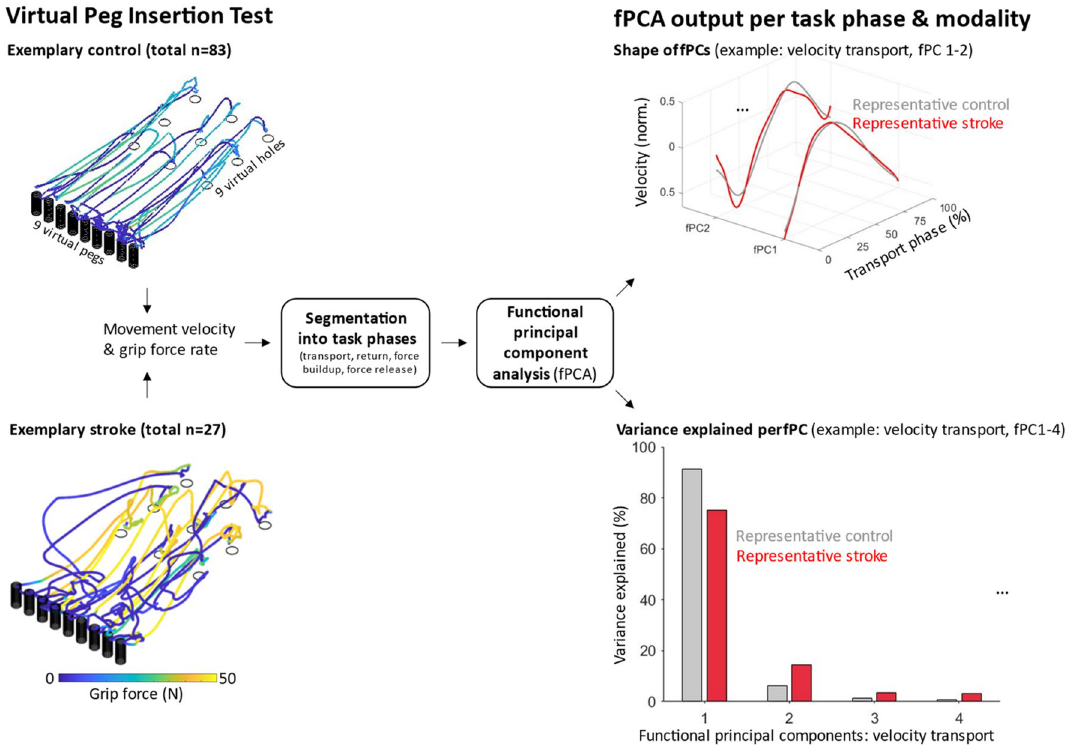
Figure 1. Overview of the approach to capture the control of arm movements and grip forces. Kinematic and kinetic time-series were collected in a control and post-stroke population using a technology-based assessment with a goal-directed functional task, the Virtual Peg Insertion Test (representative raw data in left panel). After a pre-processing and temporal segmentation (middle panel), functional Principal Component Analysis (fPCA) was applied. fPCA allows reconstructing the time-series with a set of low dimensional basis functions, named fPCs. These fPCs can have a subject-specific shape and explain certain variance of the input signal, which was compared between a representative control and post-stroke individual, indicating a similar shape of the fPCs and a different distribution of variance explained between the subjects (right panel). The control was male and 40 years old. The post-stroke individual presented a mild upper limb sensorimotor impairment according to the Fugl-Meyer assessment for the upper extremity (score 55, age 52 years,